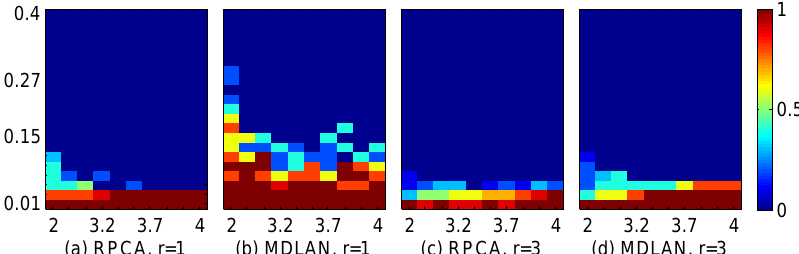
Figure 3. Recovery results with various numbers of dimensions ( m ). Comparison of RPCA and the proposed MDLAN method for rank 1 and 3 cases. The X -axis represents the log-scale row size ( log 10 m ∈ [ log 10 100, log 10 100,000 ] ) and the Y -axis represents the corruption ratio p ∈ [ 0.01,0.41 ] . The color magnitude represents the success ratio